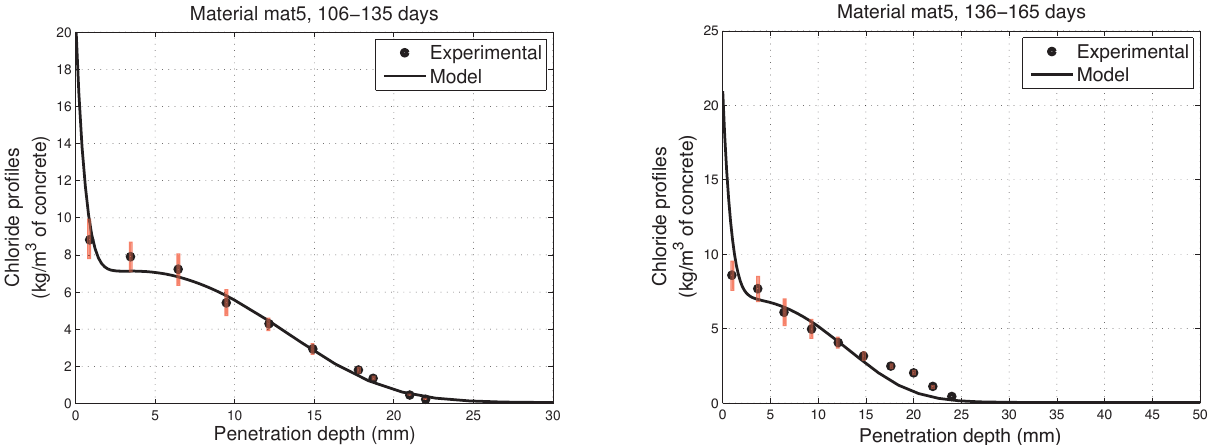
Figure 6. Experimental versus numerical solution for material mat5 and environments 3 (106–135 days) and 4 (136–165 days).